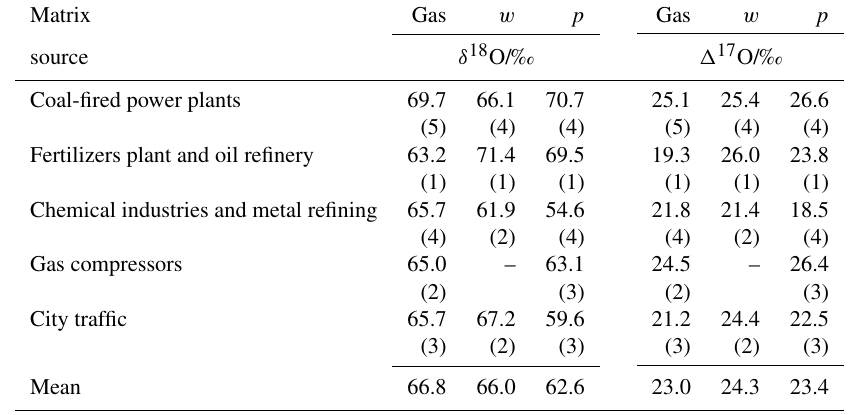
sampled as gas (HNO 3 ), w (precipitation) and p (particulate matter) relative to VSMOW. 3